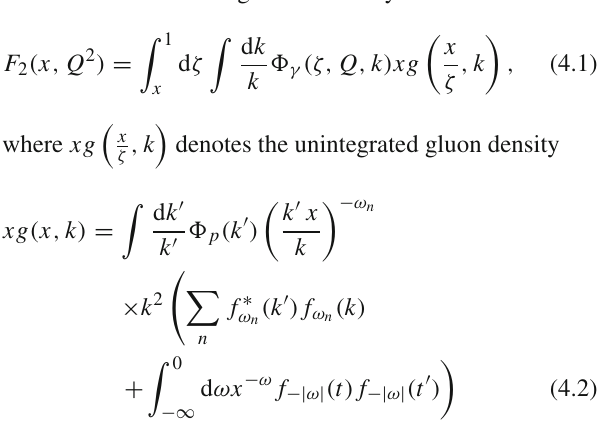
with (cid:3) QCD = 275 MeV QCD ¯ β ω n 0 /(cid:3) 2 c QCD